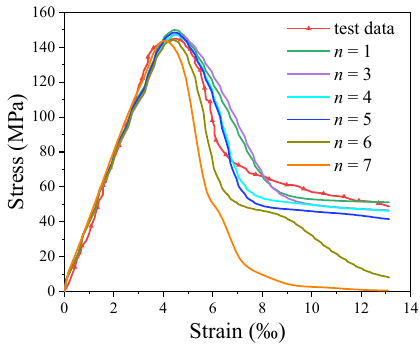
Figure 13. Uniaxial compressive curves of specimens.